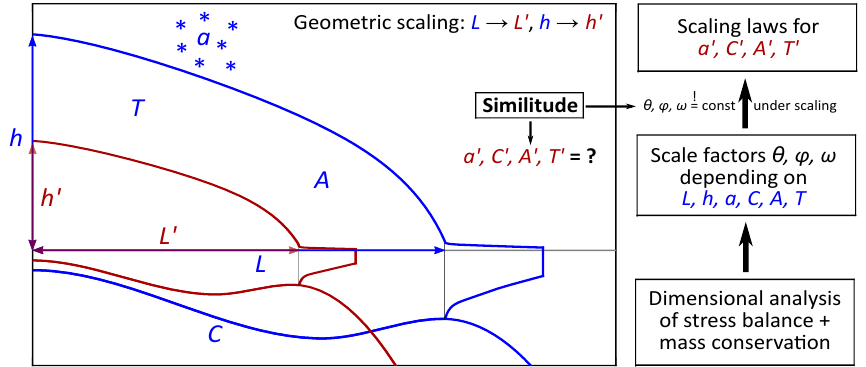
Figure 1. Schematic of the similitude-analysis method carried out in this study. A reference system (blue ice sheet and bed topography) with geometric scales h and L , timescale T and physical parameters ice softness A , basal friction coefficient C and surface mass balance a is scaled in horizontal and vertical direction (red contours, primed system). The goal is to derive the scaled parameters of the primed system under which dynamic similarity between both ice sheets holds. A dimensional analysis of the governing equations yields dimensionless scale factors which have to remain the same under scaling to attain similitude. The resulting scaling laws determine the scaled (primed) parameters.